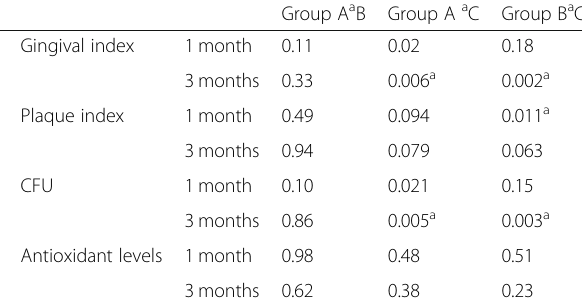
Table 3 Comparison of the test groups using Kruskal-Wallis ANOVA test